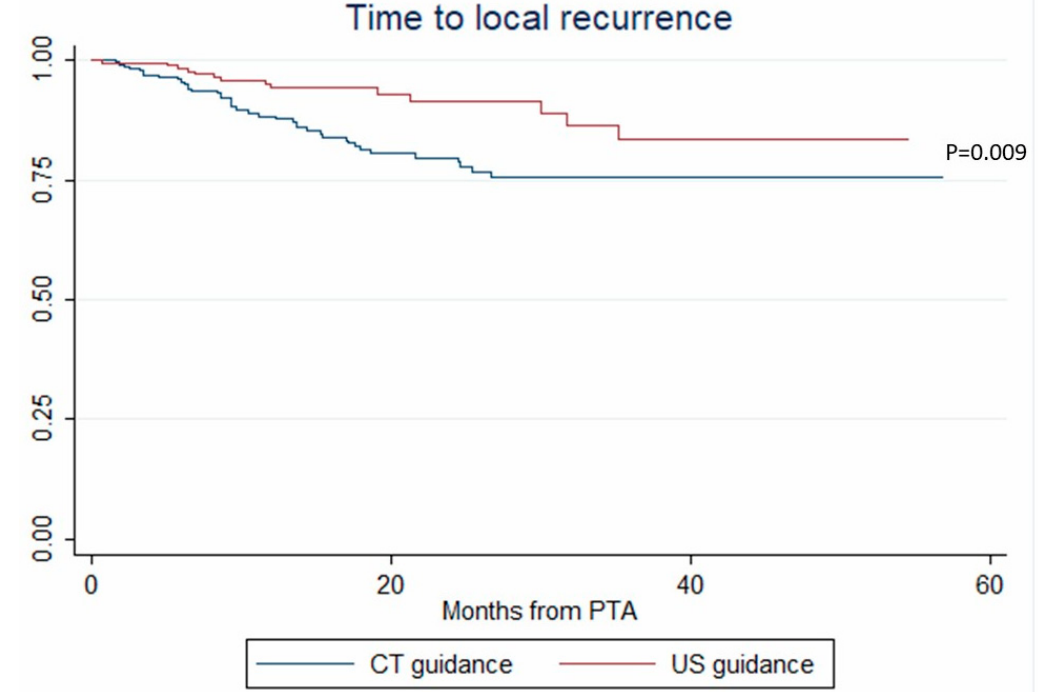
Figure 2. Time to local recurrence after percutaneous thermal ablation (PTA) under computed Figure 2. Timetolocalrecurrenceafterpercutaneousthermalablation(PTA)undercomputedtomography (CT) and ultrasonography (US) guidance (Kaplan–Meier tomography (CT) and ultrasonography (US) guidance (Kaplan–Meier analysis).